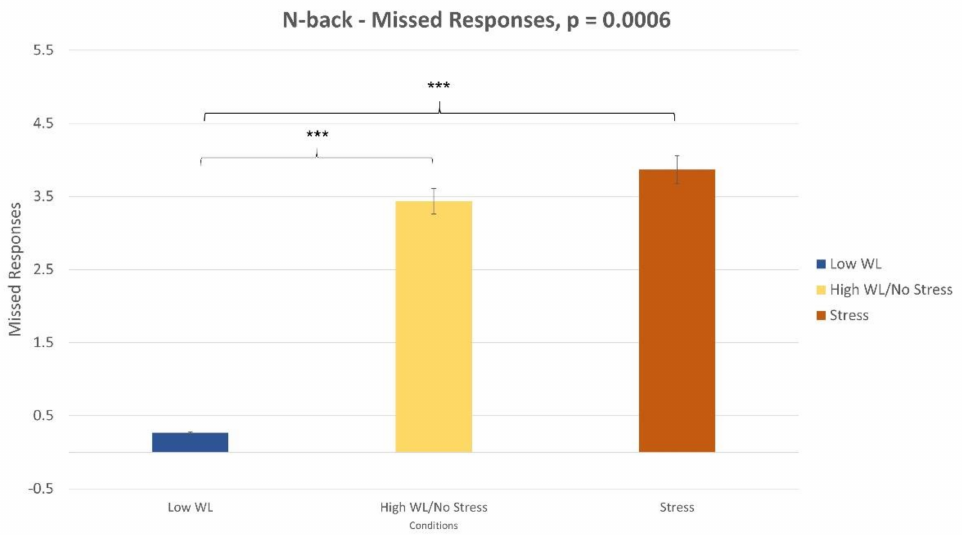
Figure 4. The number of missed responses was higher in high WL and stress conditions compared to the low WL condition ( p <